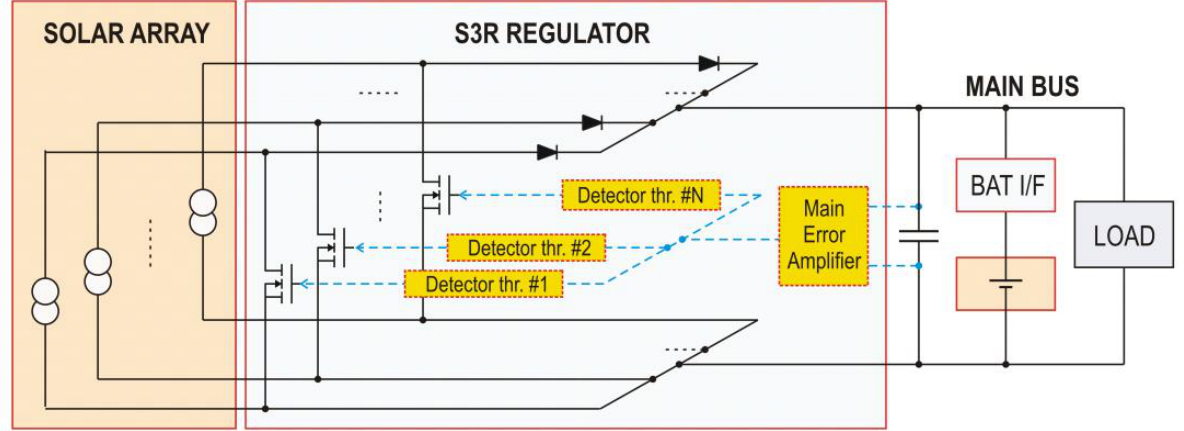
Figure 1. Power module with Sequential Switching Shunt Regulation.